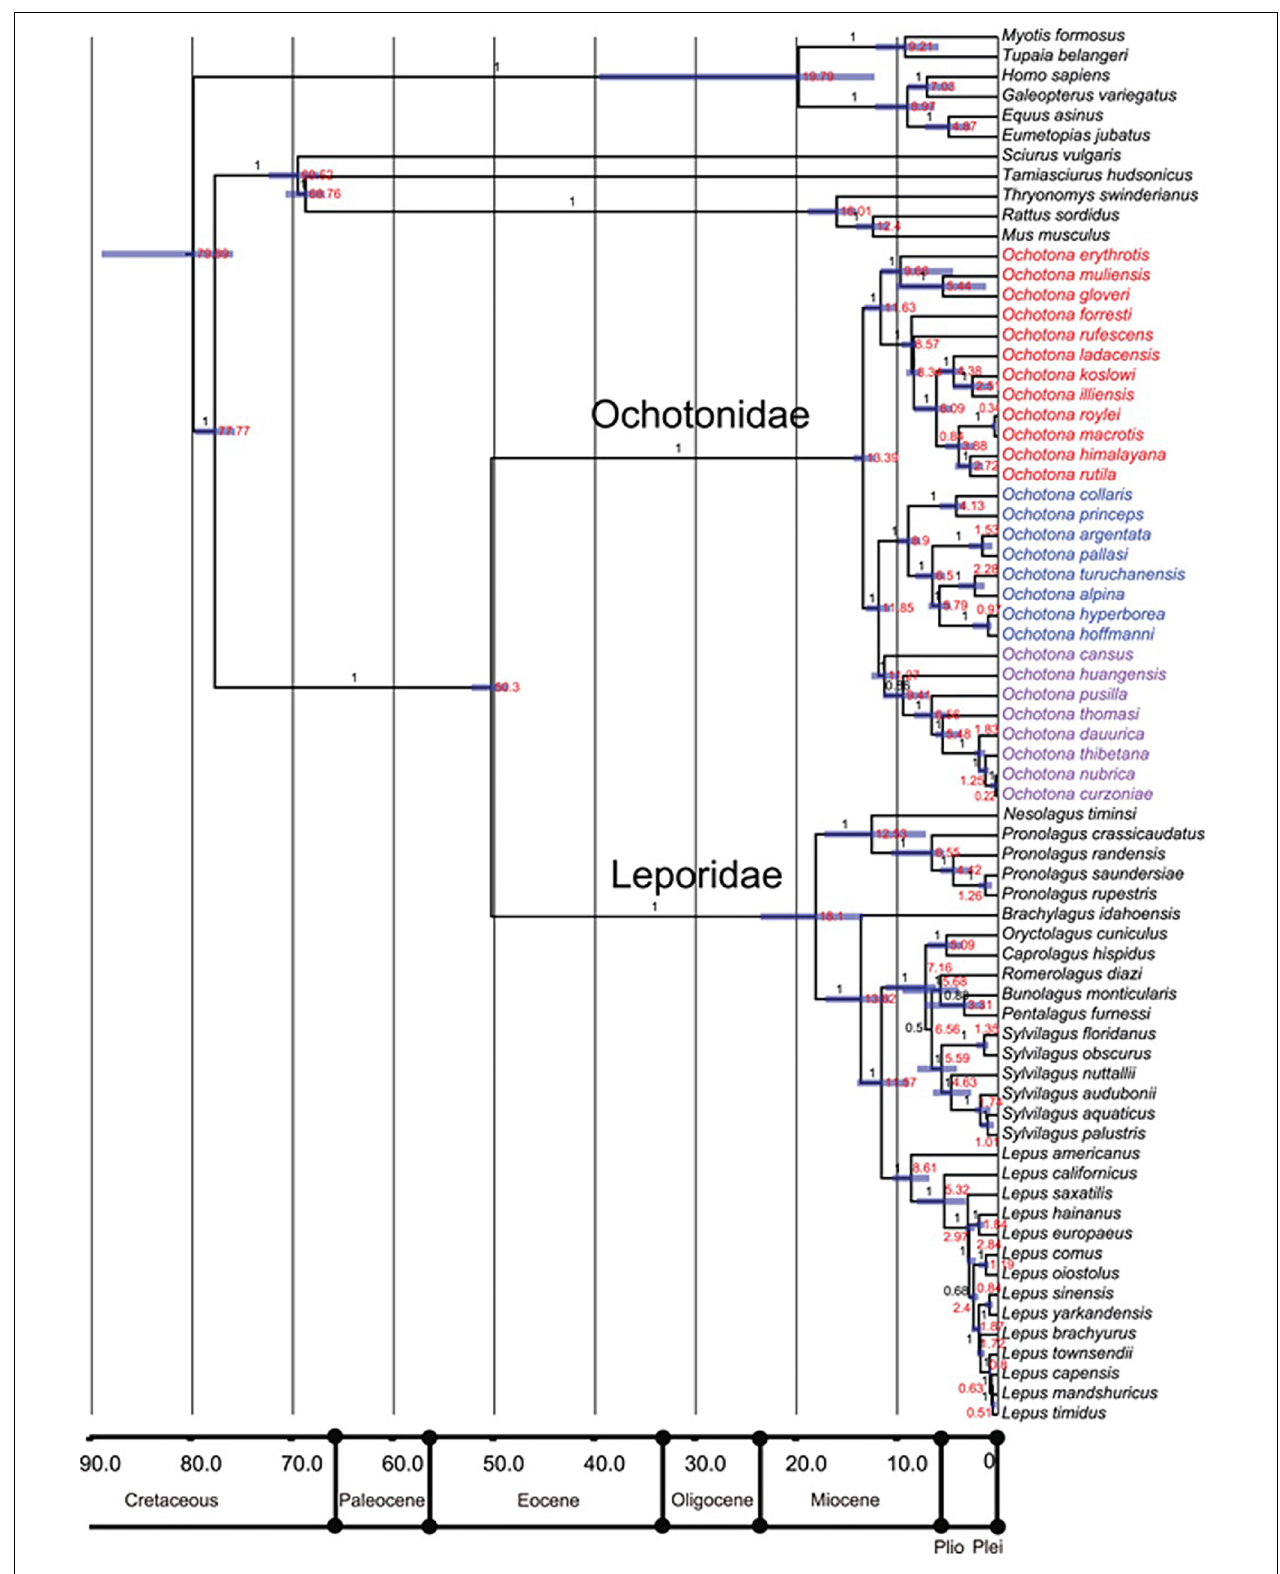
FIGURE 2 | Phylogeny of selected extant lagomorph species by Ge et al. (2013).